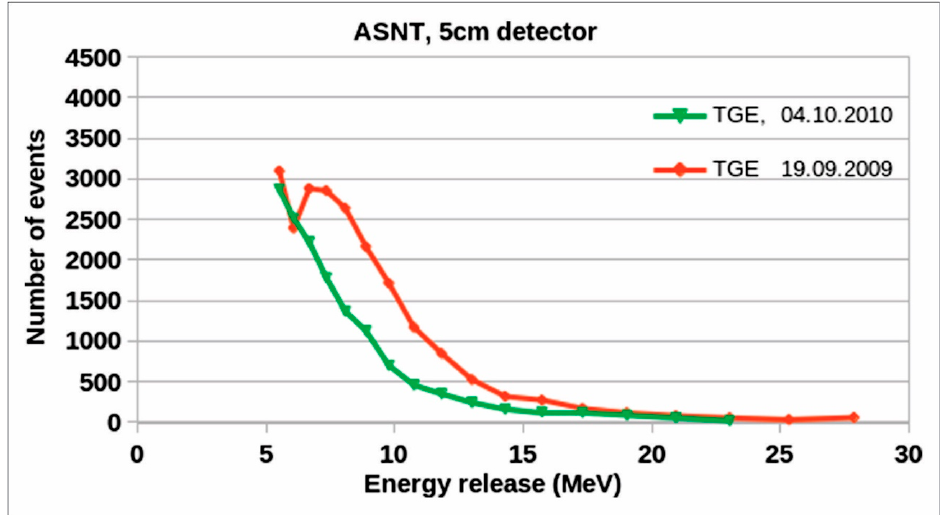
Figure 5. Energy release histograms in the 5 cm thick scintillator were measured on 19 September 2009 and 4 October 2010. ©PRD. Reproduced with permission. 2009 and 4 October 2010. ©PRD. Reproduced with